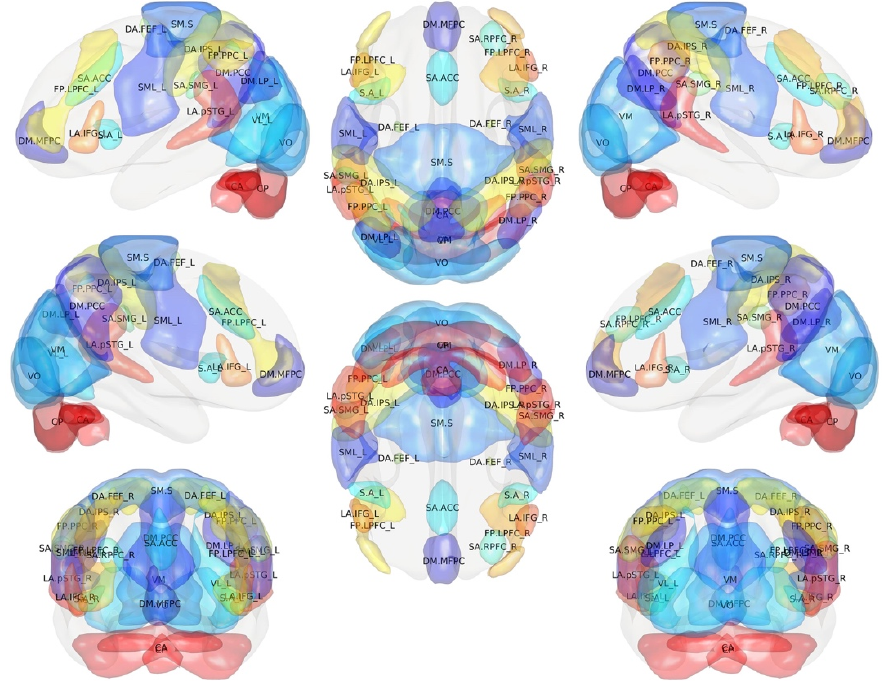
Figure 1. 3D brain surface with color map overlay reflecting the spontaneous low-frequency BOLD signal fluctuation which implies activation of distinct patterns of cerebral areas during the resting state underlying the cerebral connectivity.